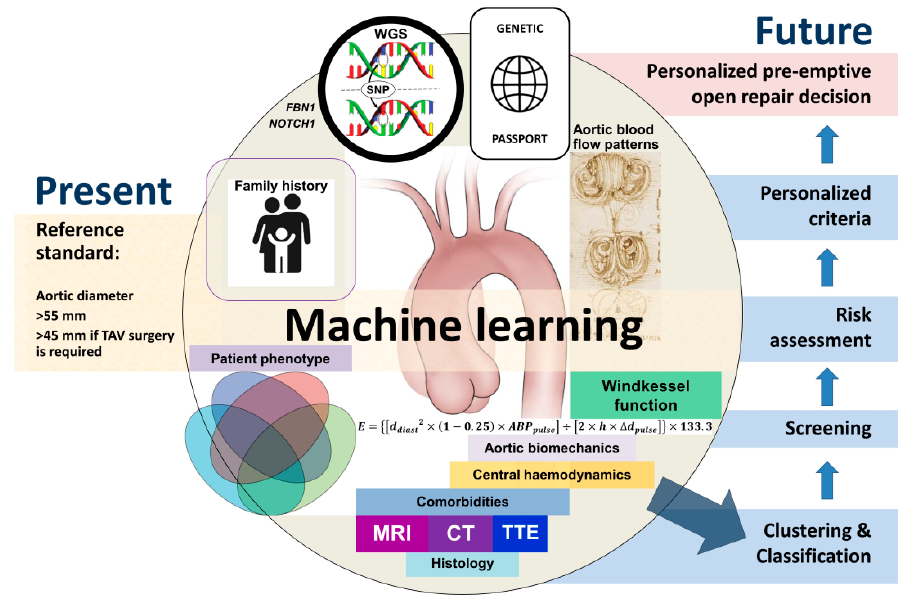
Figure 2. Proposed transdisciplinary approach to early risk assessment of ascending thoracic aortic aneurysm (MRI: magnetic resonance imaging, CT: computed tomography, TTE: transthoracic echocardiography, TAV: tricuspid aortic valve).